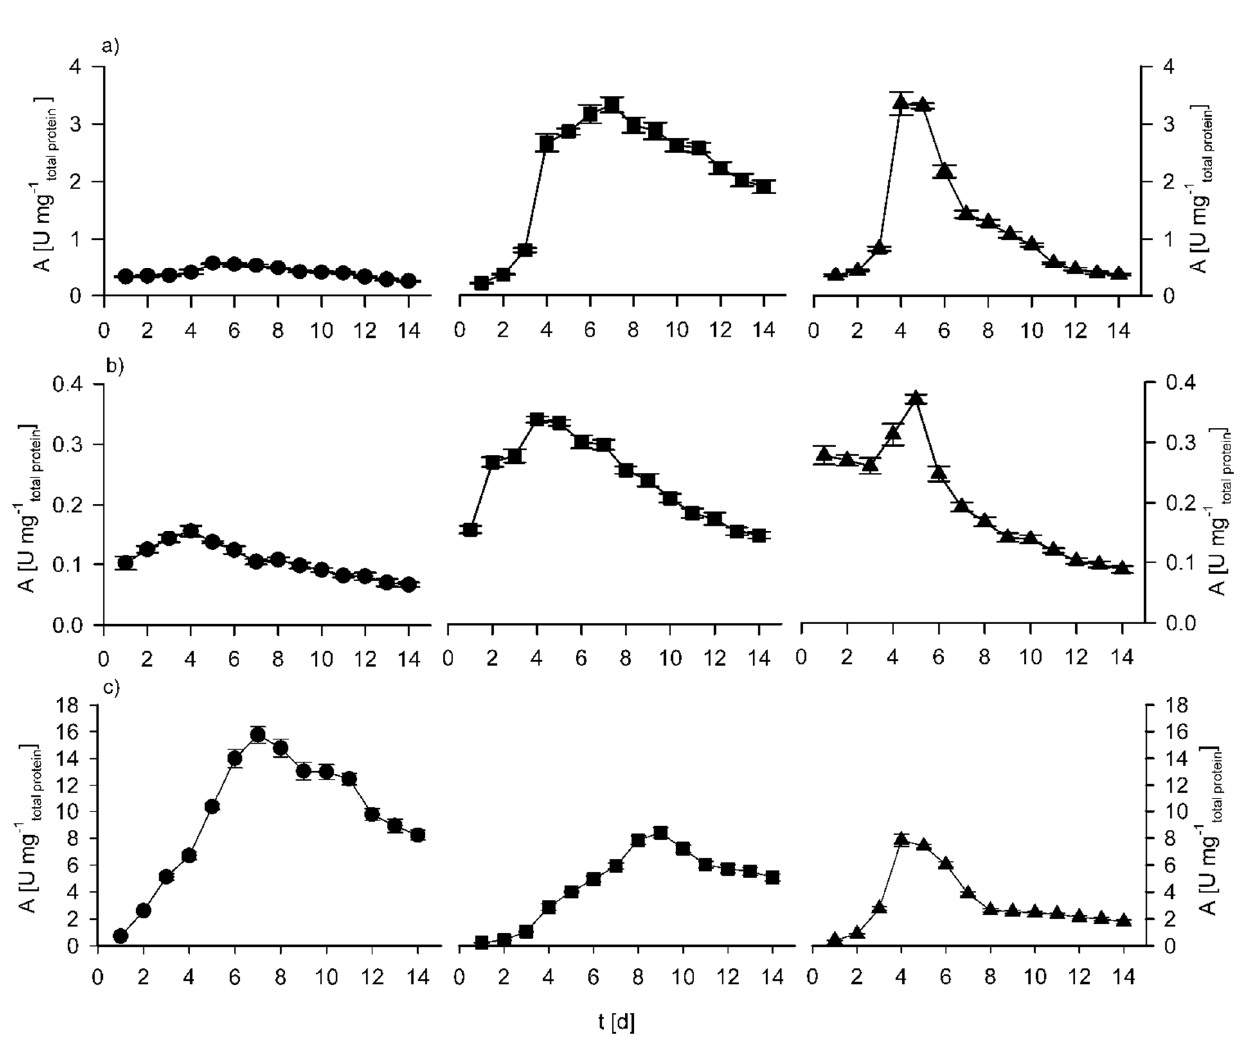
Figure 2. Change of enzymatic activity: ( a ) exoglucanase, ( b ) endoglucanase, and ( c ) xylanase during sequential solid state and submerged cultivation of FV ( • ), FO ( (cid:4) ), and mixed culture ( (cid:78) ). Bars represent the standard deviation of duplicate cultivations.